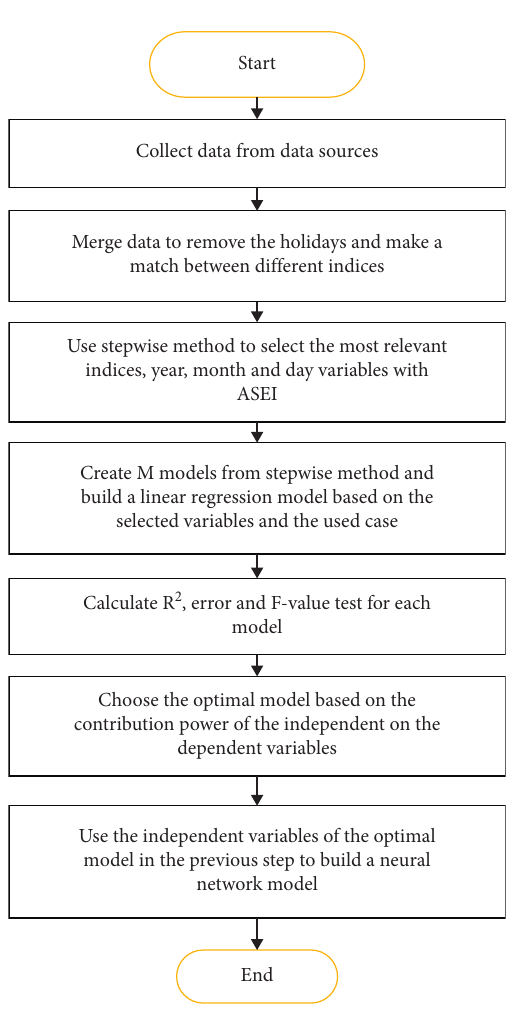
Figure 2: Flowchart of the proposed